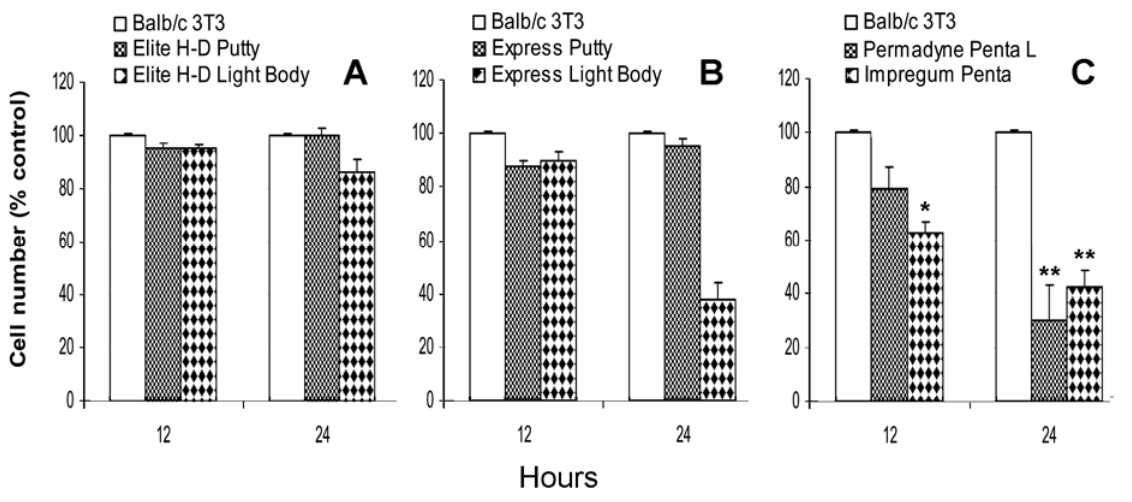
Figure 1. Direct effect of Elite H-D Putty, Elite H-D Light Body (A), Express Putty, Express Light Body (B), and Permadyne Penta L and Impregum Penta (C) on the in vitro proliferation of Balb/c 3T3 cells Data are expressed as a percentage of the untreated cells. Each graph averages the results from at least four measurements. *P <0.05, **P <0.01. One way ANOVA test and Bonferroni multiple comparison